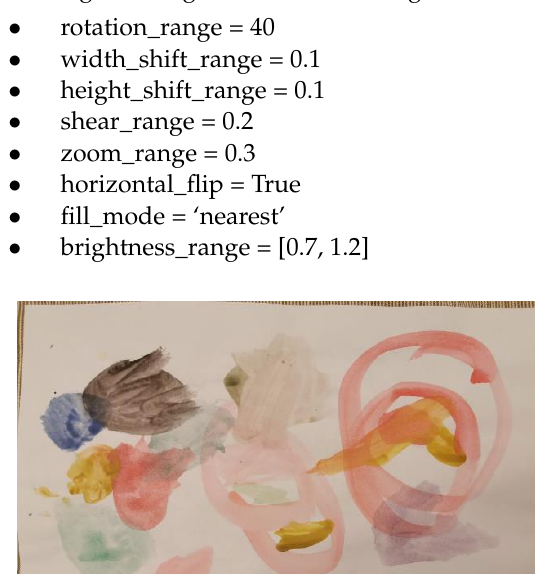
Figure 3. Drawing with Keras augmentation. First, for training the model, VGG16 (“Vision Geometry Group”) was used. For the training, the fully connected output layers of the model are not added and for weights, the “ImageNet” was utilized. The “ImageNet” dataset was considered because it contains approximatively 14 million images and every node is illustrated by hundreds and thou- sands of images [20]. This dataset is relevant, because it contains classes of animals, trees, and sports that children can draw. In addition, the database of drawings from PandaSays application has a small number of images, and transfer learning helped to reaching some valuable results. Further, three convolution dense layers with a ReLU (Rectified linear activation unit) activation function were added, in order to allow the model to learn more complex functions and to obtain better results. For com piling the model, “Adam” (adaptive moment estimation) optimizer was used, which represents an optimization algorithm that operates sparse gradients on noise, with a learning rate of 0.001 and for loss, “categorical_crossentropy”. The VGG16 model summary is described in Table 1. Next, the first 20 layers of the network were set to be non-trainable and the result is presented in Table 2; there are 14, 714, and 688 non-traina- ble parameters and 2, 102, and 277 trainable parameters. Table 1. Vgg16 model summary.